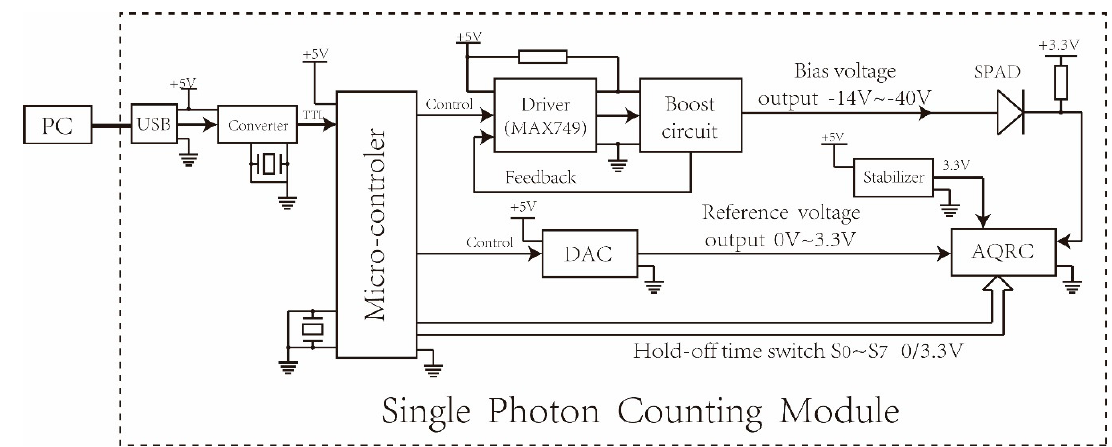
Figure 1. Block diagram of the single-photon counting module developed.